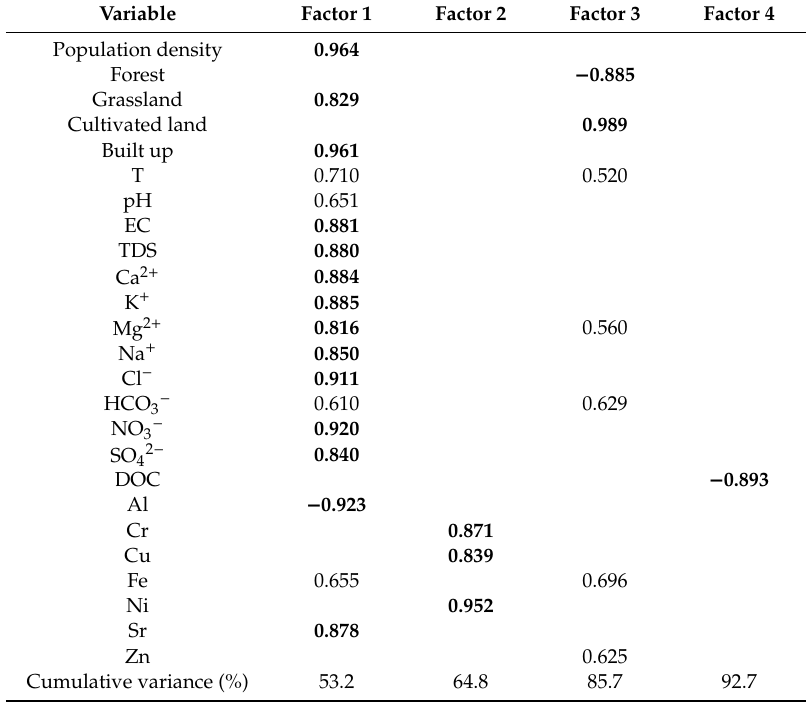
Table 5. Varimax rotated factor loading matrix from PCA for the monsoon in the Nongkrem catchment (sub-catchments: F1, F2, C1, C2, M1, M2, M3, M4, M5). Strong correlations ( ≥ 0.75) are indicated by bold type, and moderate loadings ( ≥ 0.50 and < 0.75) are shown in normal